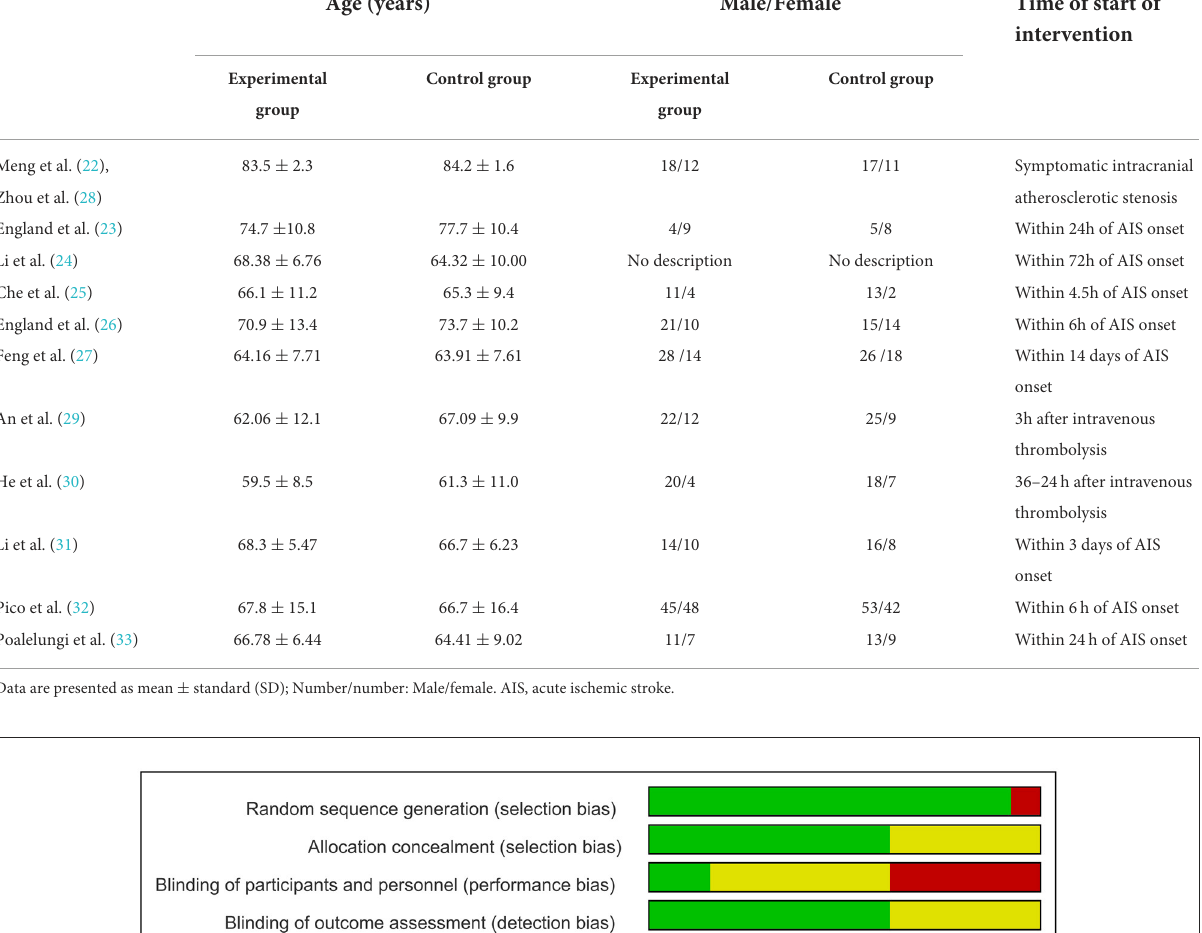
TABLE 3 Demographic information.